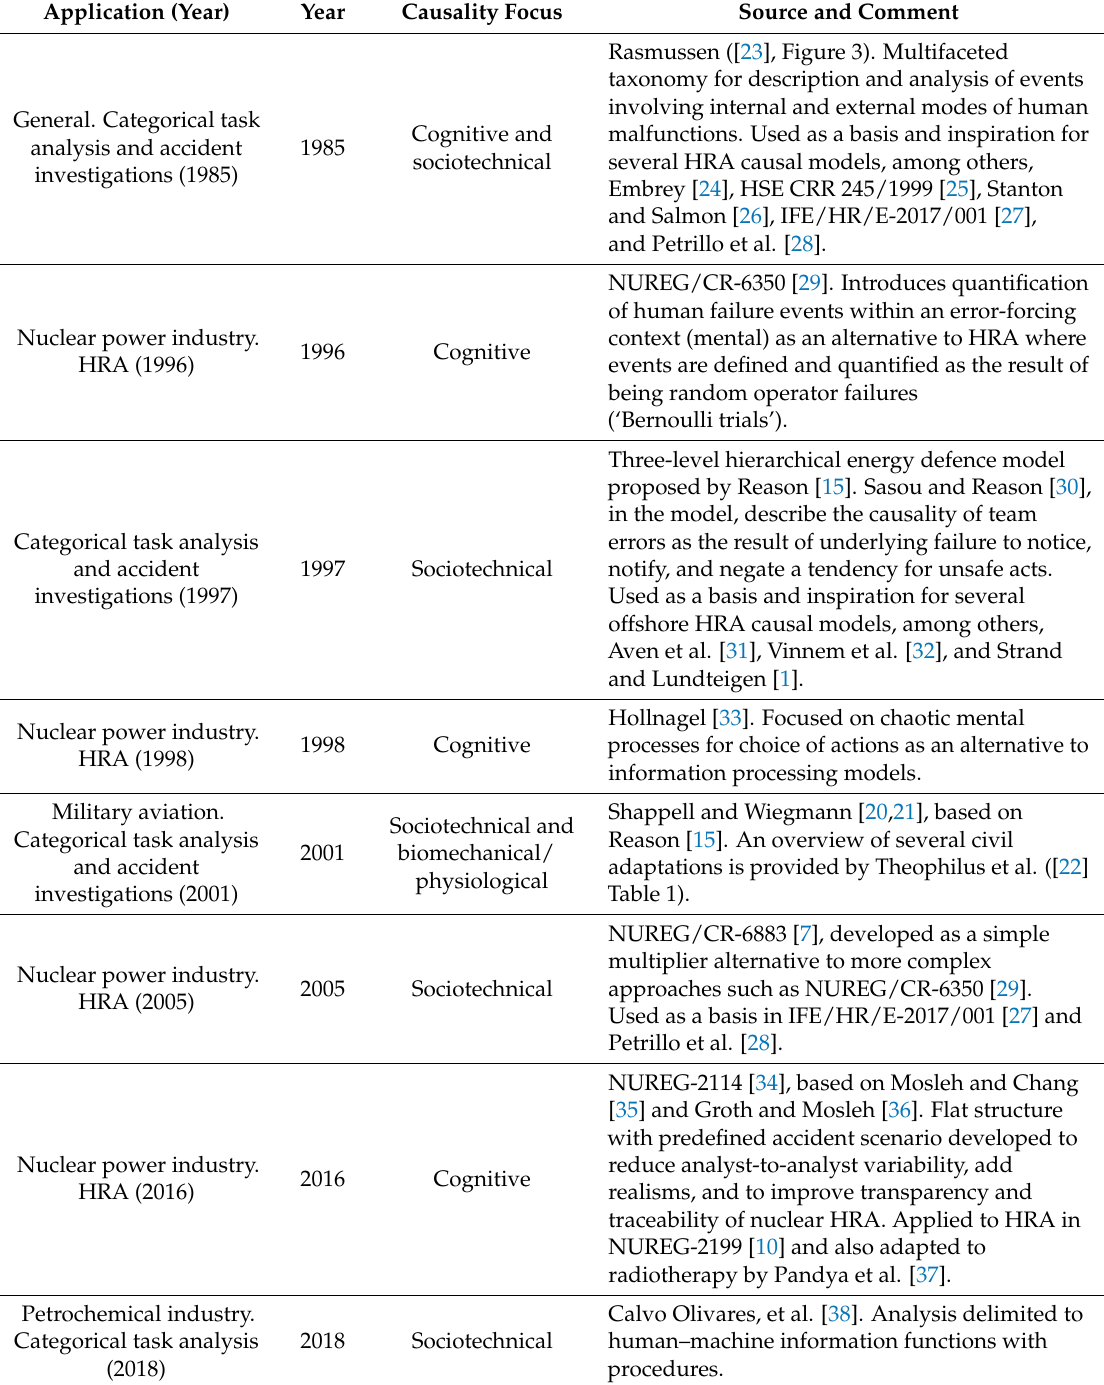
Table 1. Literature overview of causality descriptions popular in oil and gas industry human reliability analysis